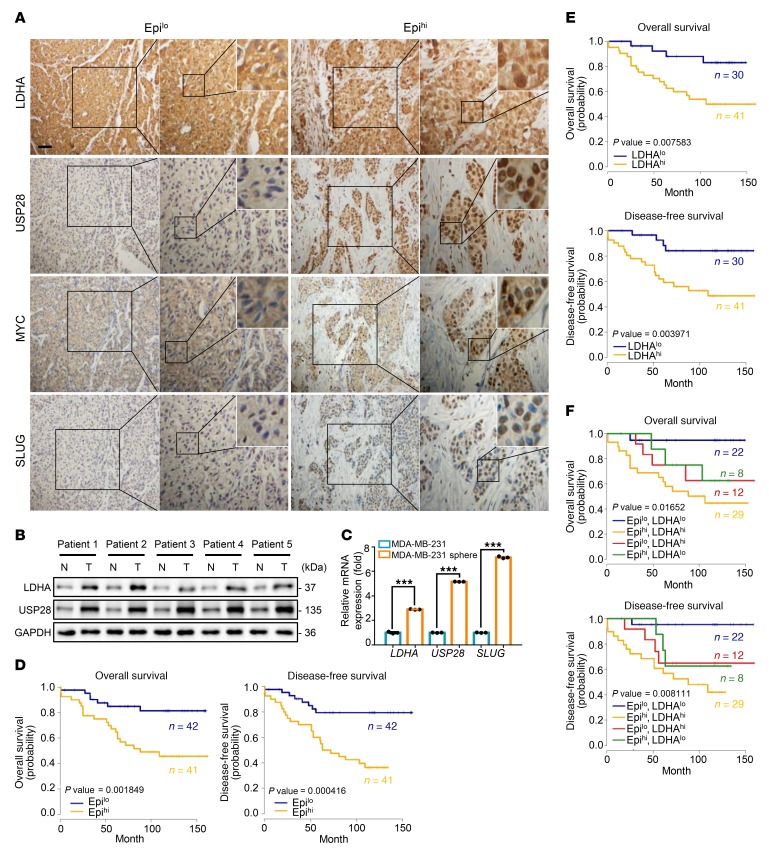
Clinical relevance of LDHA expression under chronic stress.(A) Representative immunohistochemistry photomicrographs of tissues stained with indicated antibodies in patients with breast cancer (Epilo, n = 42; and Epihi, n = 41). Scale bar: 50 μm; original magnification, ×20, ×40, ×96 (enlarged insets). (B) Immunoblot analysis of proteins in breast cancer tissues (T) and adjacent normal breast tissues (N); n = 5. (C) Expression of mRNA for the indicated genes in MDA-MB-231-2D cells or spheres was measured by quantitative reverse transcriptase PCR; n = 3 (Student’s t test). (D) Kaplan-Meier estimates of overall survival and disease-free survival of patients with breast cancer, according to the serum Epi concentrations (Epilo, n = 42; and Epihi, n = 41). Eighty-three patients were in the data set (log-rank test). (E) Kaplan-Meier estimates of overall survival and disease-free survival of patients with breast cancer, according to LDHA expression (LDHAlo, n = 30; and LDHAhi, n = 41). Seventy-one patients were in the data set (log-rank test). (F) Kaplan-Meier estimates of overall survival and disease-free survival of patients with breast cancer expressing high or low LDHA together with high or low serum Epi. Seventy-one patients were in the data set (log-rank test). Data are representative of at least 3 independent experiments. Data represent mean ± SEM; ***P < 0.001.